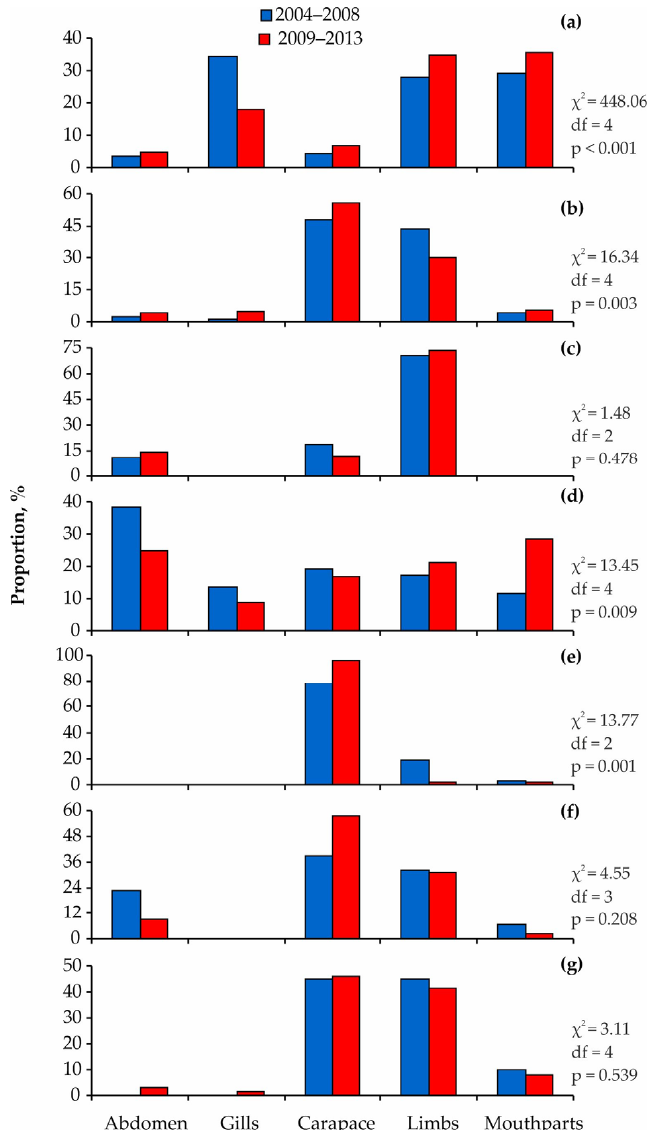
Figure 10. Comparison of localization patterns of common taxa on red king crabs from Dalnezelenetskaya Bay in summers during the 2004–2008 [33] and 2009–2013 periods. ( a ) Ischyrocerus commensalis , ( b ) Ischyrocerus anguipes , ( c ) Hirudinea, ( d ) Mytilus edulis , ( e ) Balanus crenatus , ( f ) Bryozoa, ( g ) Hydrozoa.